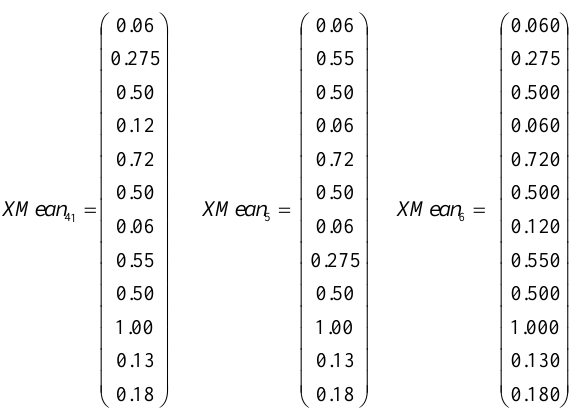
Table 9. Final linguistic labels for the output variables in the district “San